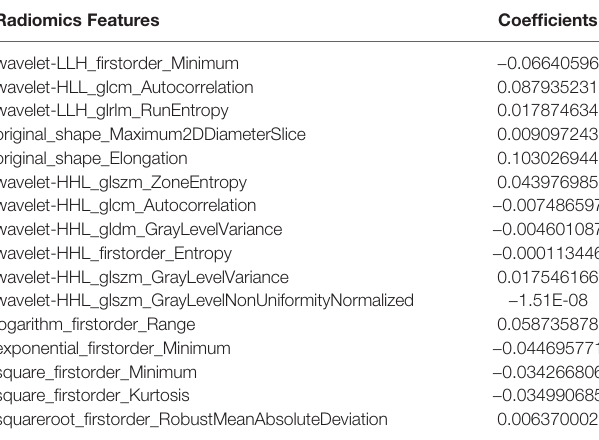
TABLE 2 | Least absolute shrinkage and selection operator (LASSO) coef fi cient pro fi les of the 16